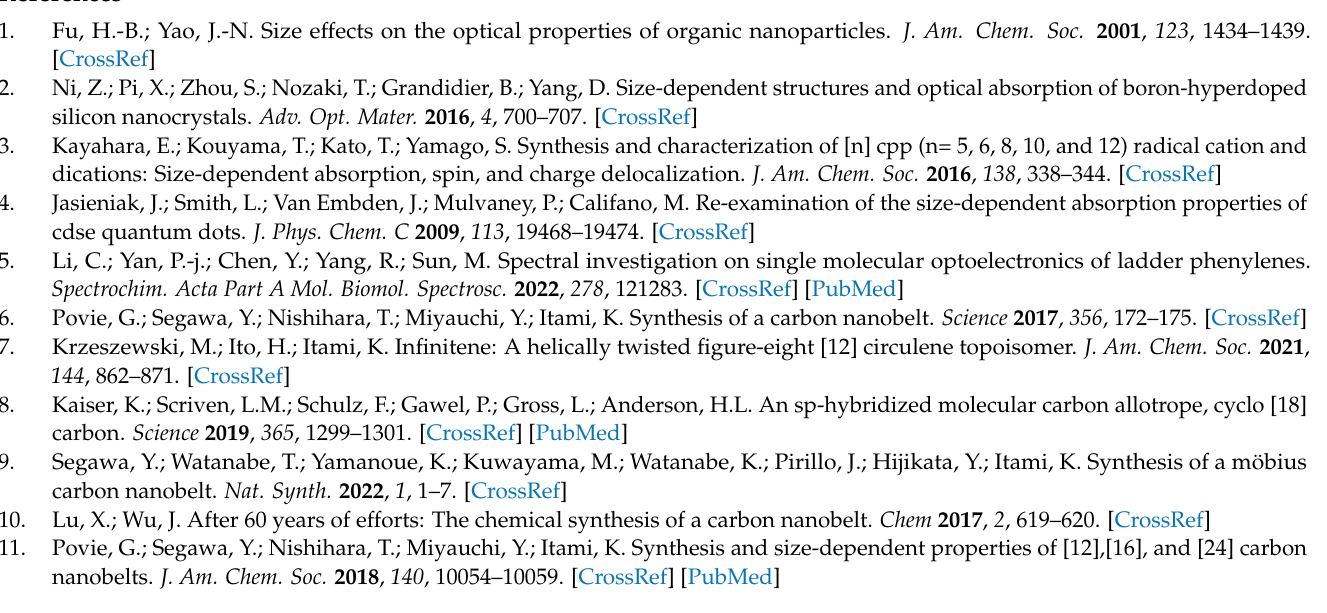
Figure S4. CDD of S0 → S12 → S46 and S0 → S13 → S46 in the TPA of [12,12]CNB. Figure S5. CDD of S0 → S12 → S53 and S0 → S13 → S53 in the TPA of [14,14]CNB. Figure S6. CDD of S0 → S14 → S56 and S0 → S15 → S56 in the TPA of [16,16]CNB. Figure S7. Vibrational modes of [4,4]CNB at 908.0, 1312.4, 1477.2, 1540.7 and 3190.1 cm − 1 . Figure S8. Vibrational modes of [6,6]CNB at 918.2, 1344.7, 1479.3, 1548.1 and 3193.1 cm − 1 . Figure S9. Vibrational modes of [8,8]CNB at 921.6, 1354.0, 1480.9, 1556.6 and 3196.1 cm − 1 . Figure S10. Vibrational modes of [10,10]CNB at 926.6, 1358.2, 1482.0, 1562.0 and 3197.9 cm − 1 . Figure S11. Vibrational modes of [12,12]CNB at 929.5, 1360.3, 1482.7, 1565.3 and 3198.8 cm − 1 . Figure S12. Vibrational modes of [14,14]CNB at 903.9, 1390.3, 1497.1, 1515.9 and 3286.6 cm − 1 . Figure S13. Vibrational modes of [16,16]CNB at 905.6, 1391.5, 1498.5, 1516.4 and 3287.0 cm − 1 ; Table S1. Orbital contribution of S 18 of [4,4]CNB. Table S2. Orbital contribution of S19 of [4,4]CNB. Table S3. Orbital contribution of S13 of [6,6]CNB. Table S4. Orbital contribution of S 14 of [6,6]CNB. Table S5. Orbital contribution of S 13 of [8,8]CNB. Table S6. Orbital contribution of S14 of [8,8]CNB. Table S7. Orbital contribution of S12 of [10,10]CNB. Table S8. Orbital contribution of S13 of [10,10]CNB. Table S9. Orbital contribution of S12 of [12,12]CNB. Table S10. Orbital contribution of S13 of [12,12]CNB. Table S11. Orbital contribution of S12 of [14,14]CNB. Table S12. Orbital contribu- tion of S13 of [14,14]CNB. Table S13. Orbital contribution of S12 of [16,16]CNB. Table S14. Orbital contribution of S13 of